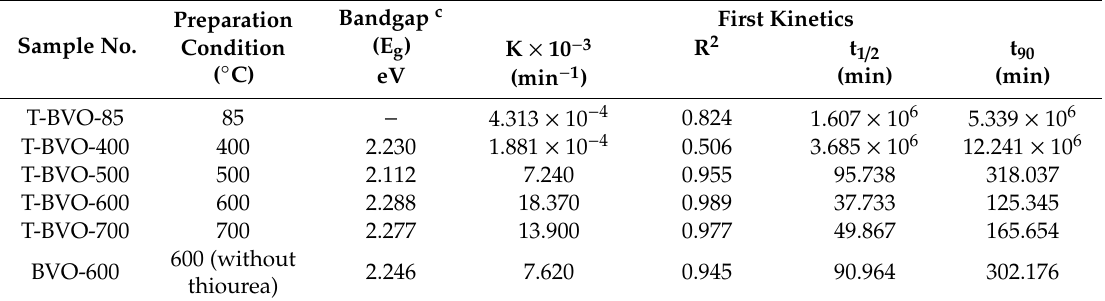
Table 3. The bandgap energy of the samples and the rate constants (k) values of the samples for MB